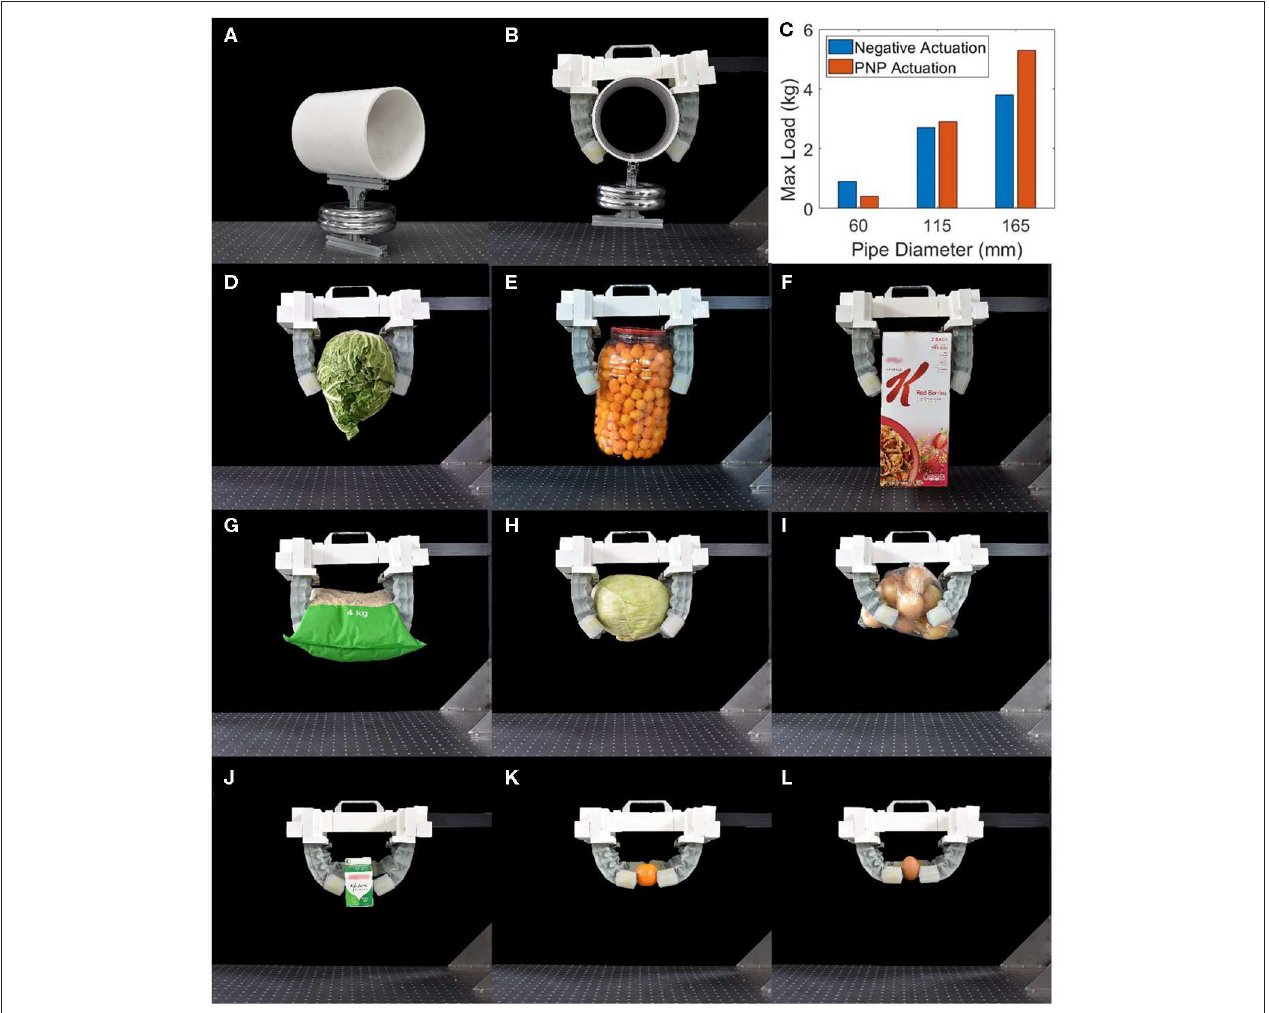
FIGURE 4 | (A) Testing jig for maximum load vs. pipe diameter experiment (165mm diameter pipe pictured), (B) gripper grapping the jig using PNP actuation, and (C) results for the maximum load for different pipe diameters. The gripper using PNP actuation for grasping (D) a head of cabbage (2.20kg), (E) a large jar of cheese puffs (0.55kg), (F) a large-sized box of cereals (1.30kg), (G) a bag of rice (4.00kg), (H) a head of cabbage (2.00kg), and (I) a bag of onions (1.20kg). The gripper using negative pressure actuation to grab (J) a carton of milk (0.28kg), (K) a tangerine (0.06kg), and (L) a boiled egg